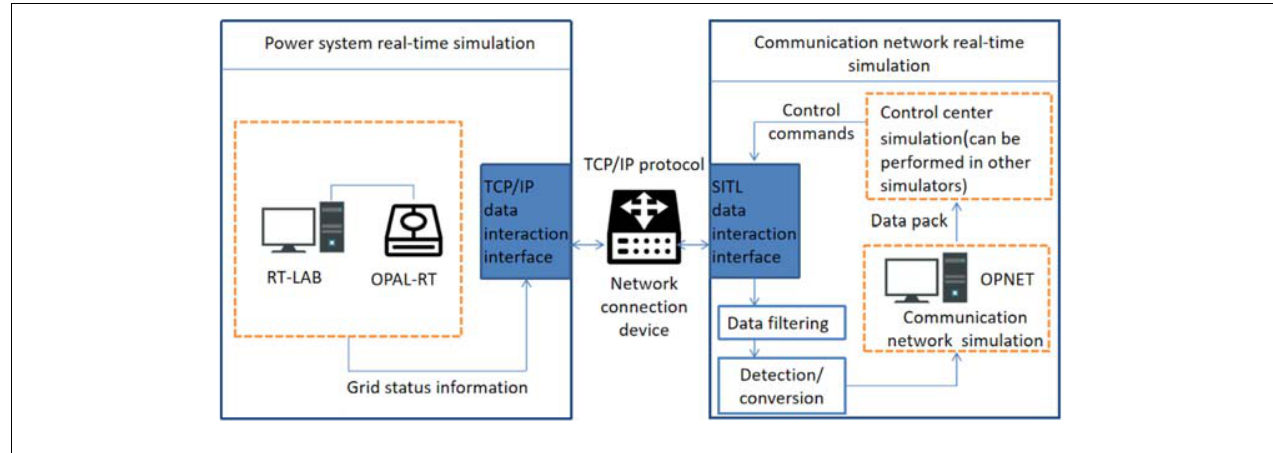
FIGURE 3 | Structure of real-time co-simulation using RT-LAB and OPNET.